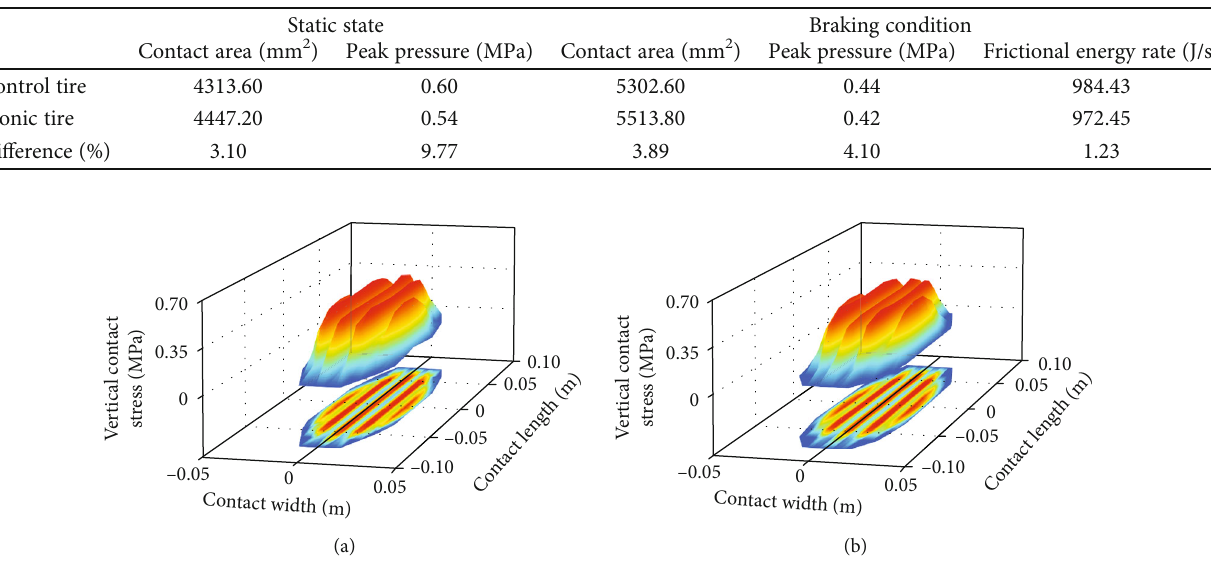
Figure 9: Contact patch and pressure distribution under braking conditions: (a) control tire; (b) bionic tire. Table 4: Comparison under steering